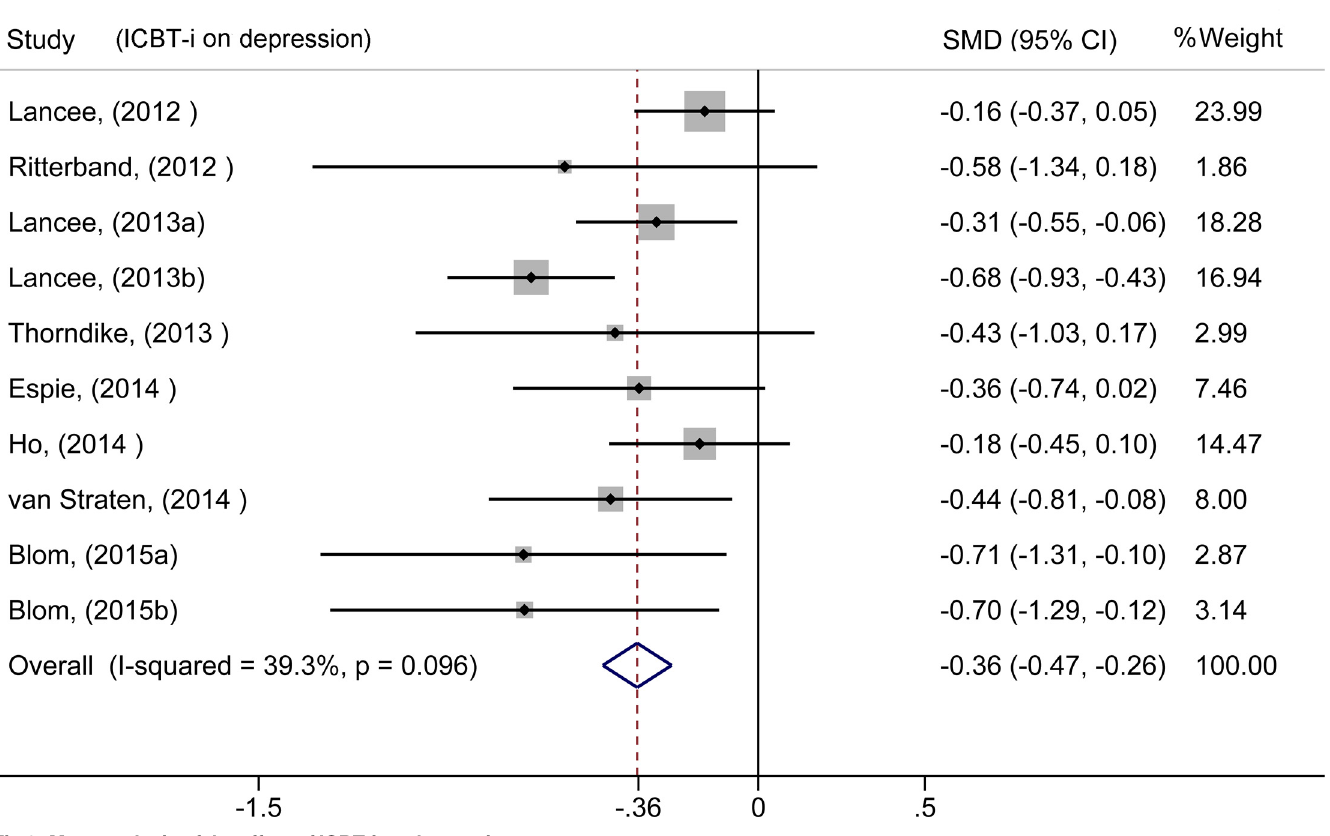
Fig 3. Meta-analysis of the effect of ICBT-i on